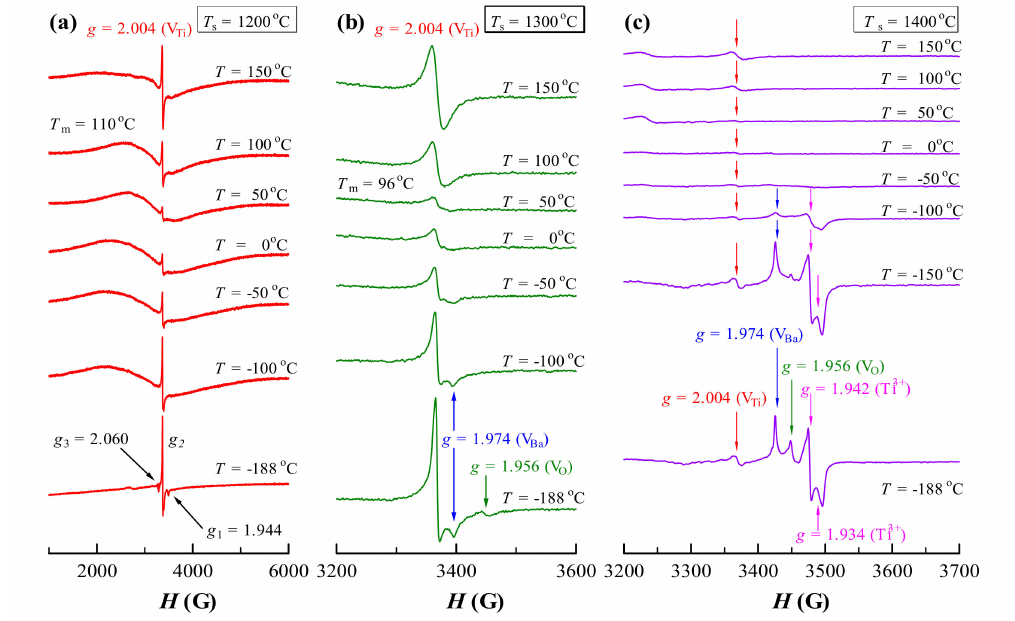
Figure 5. Temperature-dependent EPR spectra for BM1T sintered at T s = ( a ) 1200, ( b ) 1300, and ( c ) 1400 ◦